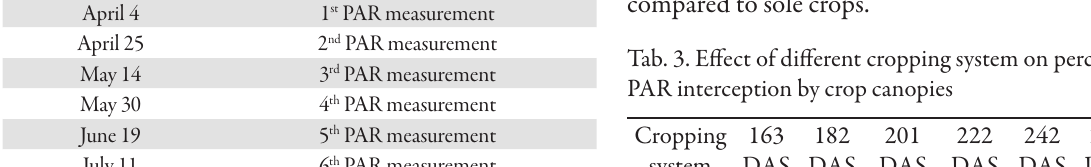
Tab. 3. Effect of different cropping system on percentage of PAR interception by crop canopies Cropping